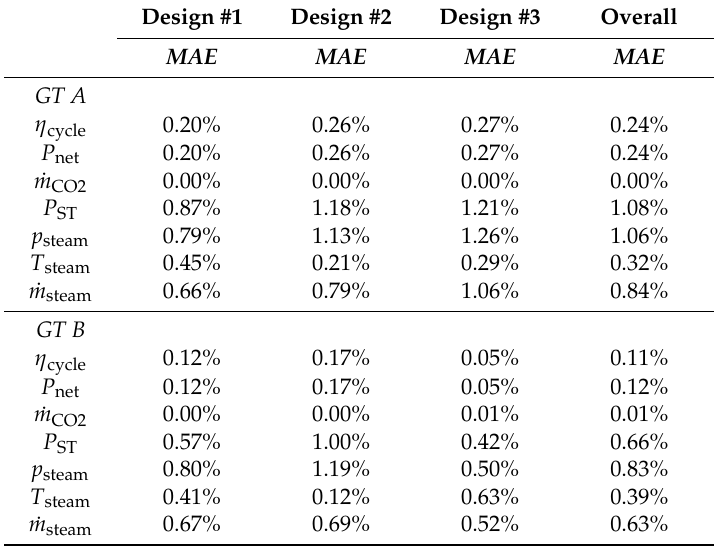
Table A3. Mean average error (MAE) from the off-design simulations for some selected